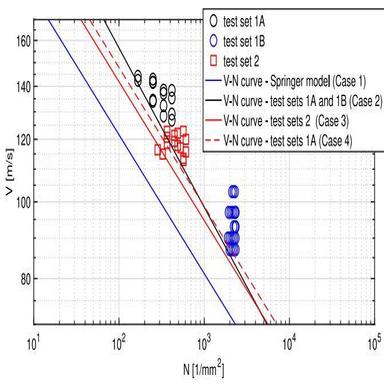
V-N RET test sets and fitted curves for Cases 1–4.